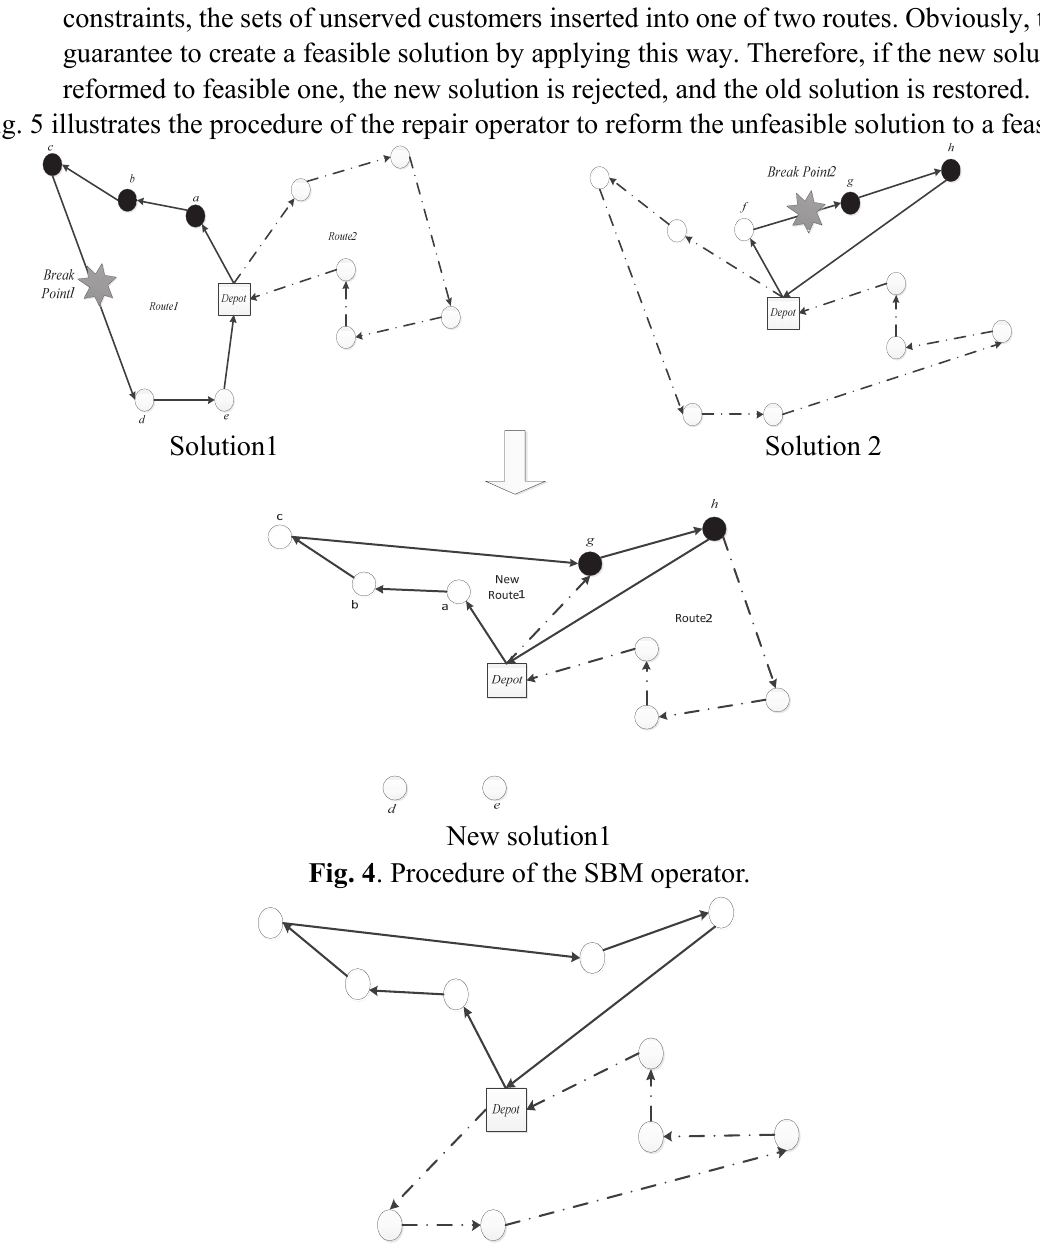
Fig. 5 . Procedure of a repair